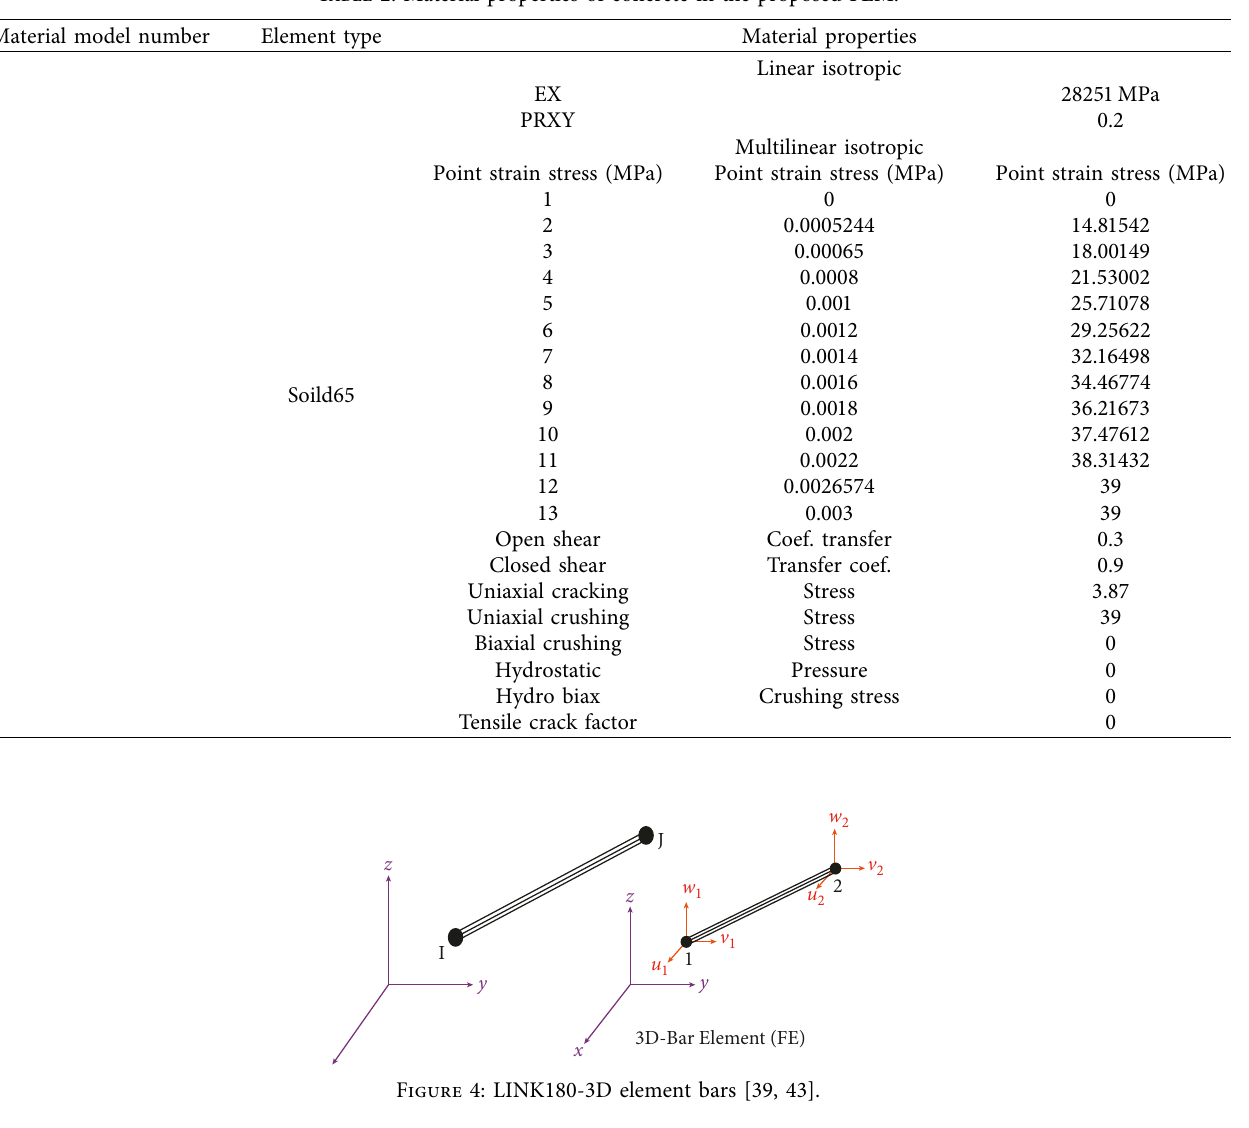
Table 2: Material properties of concrete in the proposed FEM.